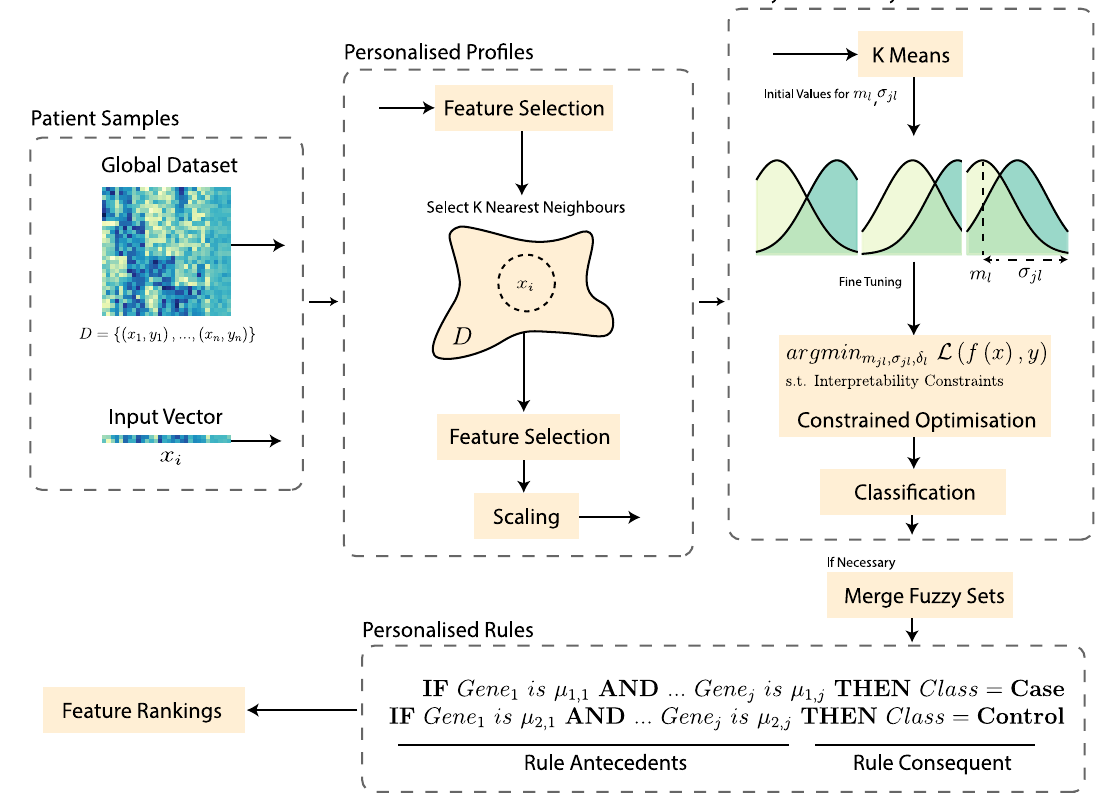
Figure 1. The proposed personalized constrained neuro fuzzy inference (PCNFI) methodology. First, a personal profile is built for the input patient by selecting K Nearest Neighbours (KNN) from the training set. The first layer of feature selection helps in selecting the best neighbours and the second layer (after KNN) helps to improve the structural interpretability of the rules. Next, the fuzzy inference system is initialised by K-Means and fine-tuned via constrained optimisation to ensure semantic interpretability. Following this, redundant fuzzy sets can be merged if the number of rules is high. Finally, personalised fuzzy rules can be extracted based on the genetic profiles of